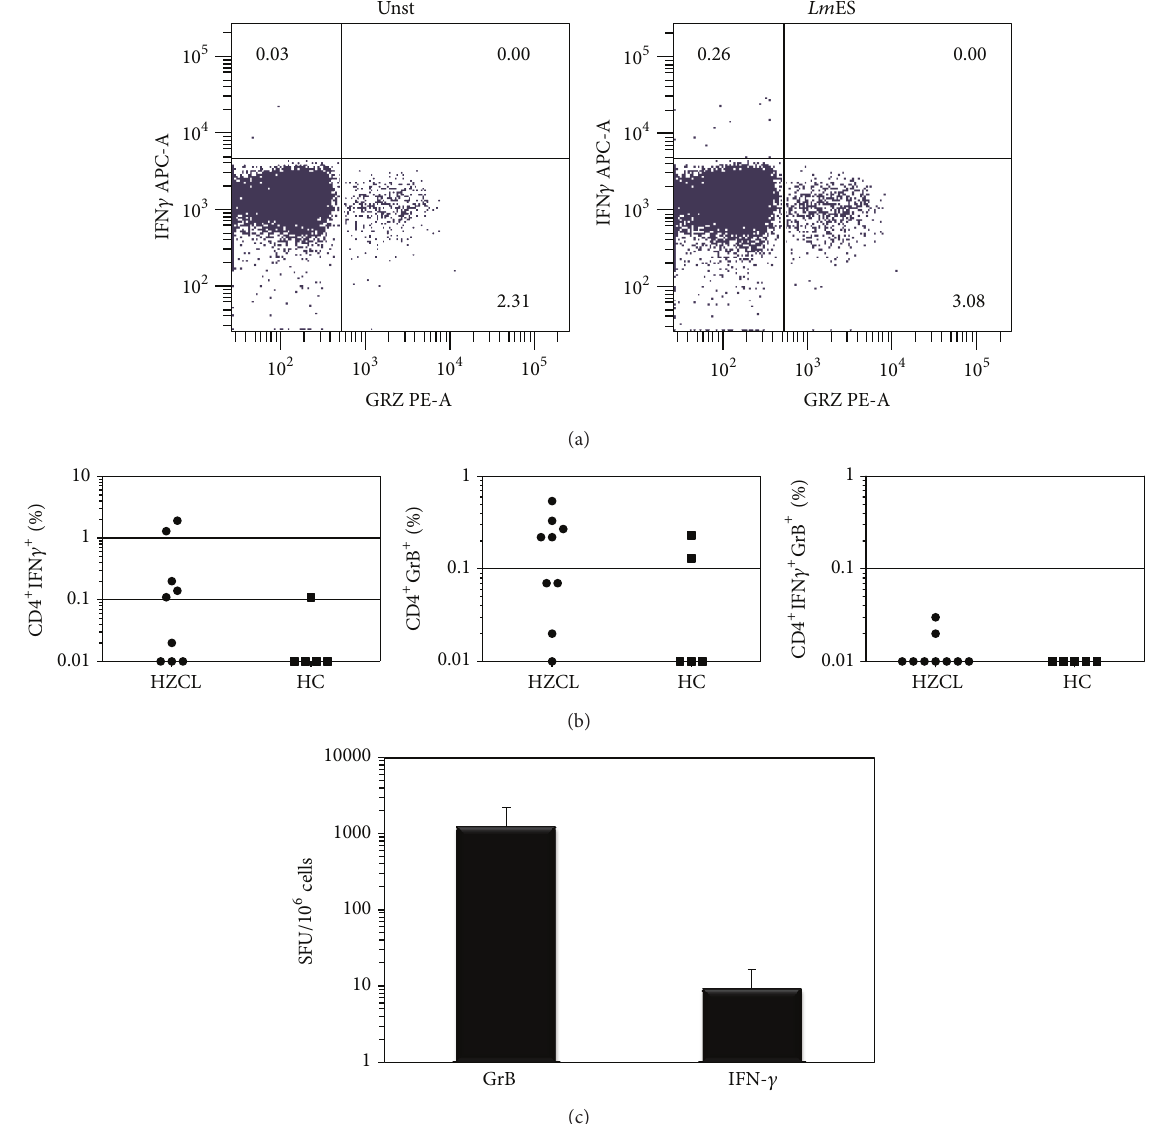
Figure 4: GrB and IFN- 𝛾 are produced by different subsets of CD4 + T cells. (a) Representative example of FACS analyses of PBMCs from HZCL incubated in culture medium alone (Unst) or in presence of proteins ( Lm ES) and analyzed for the expression of GrB and IFN- 𝛾 . Results are shown as percentages of positive cells inside the CD4 + T cells gate. (b) shows percentages of CD4 + T cells positive for GrB, IFN- 𝛾 and those double positive in 9 HZCL and 5 HC. Results are expressed as the mean ± standard error of the mean of levels. (c) CD4 + T cells were purified from the peripheral blood of 4 HZCL incubated with Lm ES in vitro in presence of mitomycin C-treated autologous PBMCs (APCs) and analysed by a dual color ELISpot specific for GrB and IFN- 𝛾 . Results are expressed as the mean ± standard error of the mean of SFU/10 6